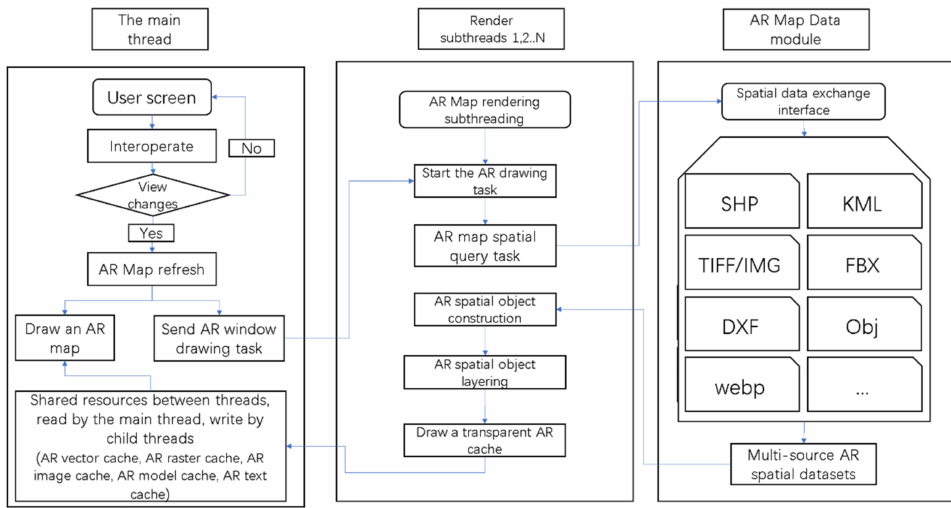
Figure 7. The multi-threaded acceleration method for AR vector map